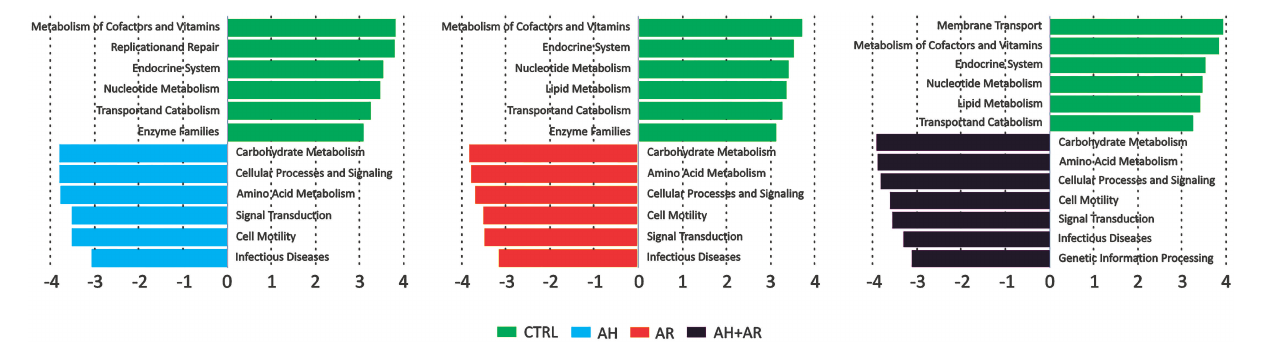
FIGURE 6 | Results of LEfSe method performed on the relative abundances of KEGG pathways at L2 level obtained by reconstructing metagenomes with the PICRUSt algorithm. Pairwise comparisons were performed separately between each diseased groups and the control one. A FDR adjusted p -value ≤ 0.05, as well as an LDA score ≥ 3, were used as thresholds to identify significant